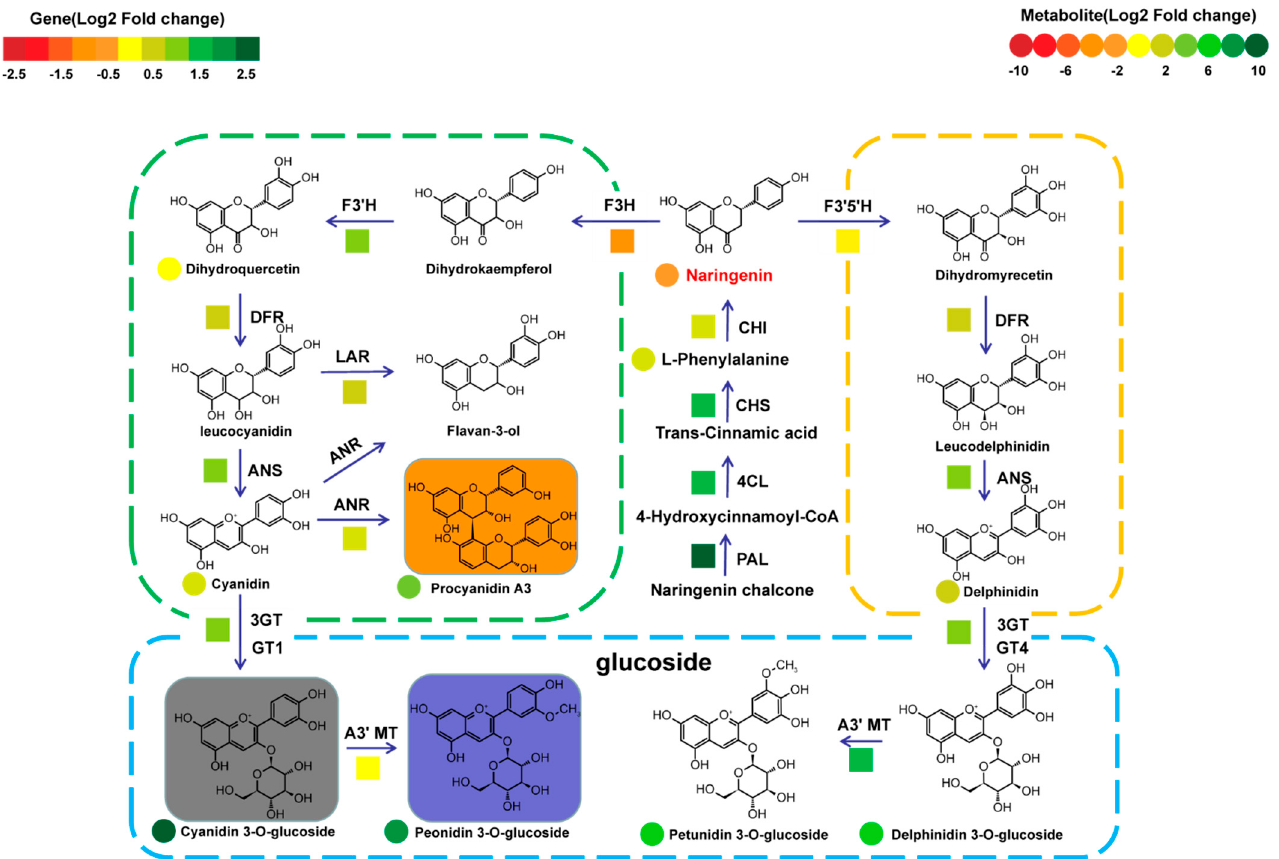
Figure 6. Integrated transcriptomic and metabolomic data to exhibit the anthocyanin synthesis path- way in the germination seeds of cultivar rice and landrace. A heatmap represents the folds of the expression levels of the corresponding structural genes in the seeds of landraces and cultivated rice, and from red to green in the heatmap indicates the expression levels of structural genes ranging from low to high. Genes in anthocyanin synthesis are shown as follows: PAL , phenylalanine ammo- nia lyase; C4H , cinnamate 4-hydroxylase; 4CL , 4-coumarate CoA ligase; CHS , chalcone synthase; CHI , chalcone isomerase; F3H , flavanone 3-hydroxylase; F3 ′ H , flavonoid 3 ′ -hydroxylase; F3 ′ 5 ′ H , flavonoid 3 ′ ,5 ′ -hydroxylase; DFR , dihydroflavonol reductase; ANS , anthocyanidin synthase; flavonoid 3- O -glucosyltransferase; 3GT , flavonoid 3- O -glucosyltransfers; GT1 , glucosyltransferase 1; GT4 , glucosyltransferase